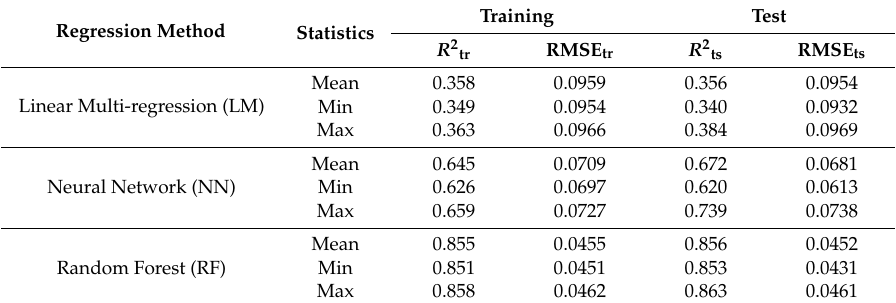
Table 1. Predictive model based on Machine Learning and Perturbation Theory (PTML) statistics for the evaluation of mitochondrial oxygen flow modifications due to CNTs (10 random splits for each